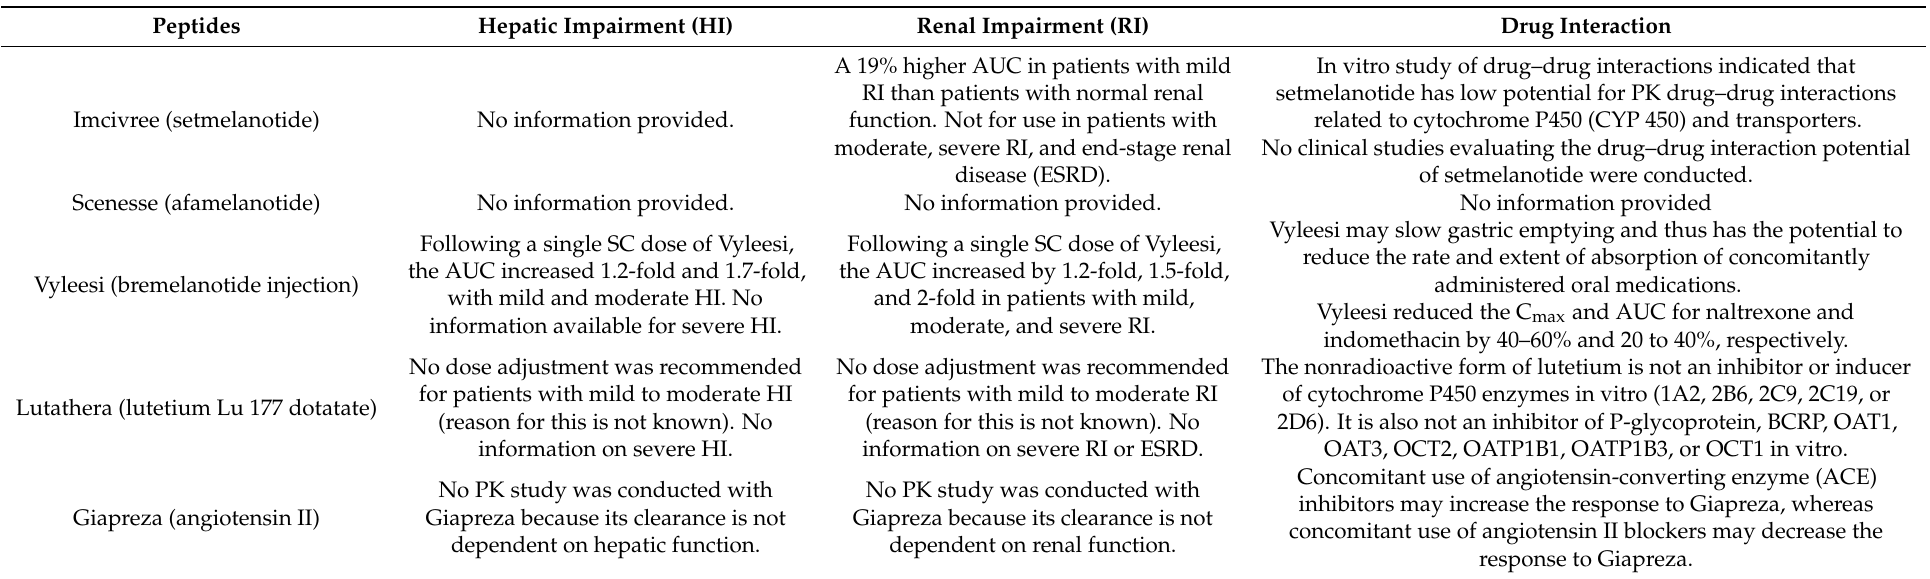
Table 3. Drug interaction and impact of hepatic and renal impairment on the pharmacokinetics of